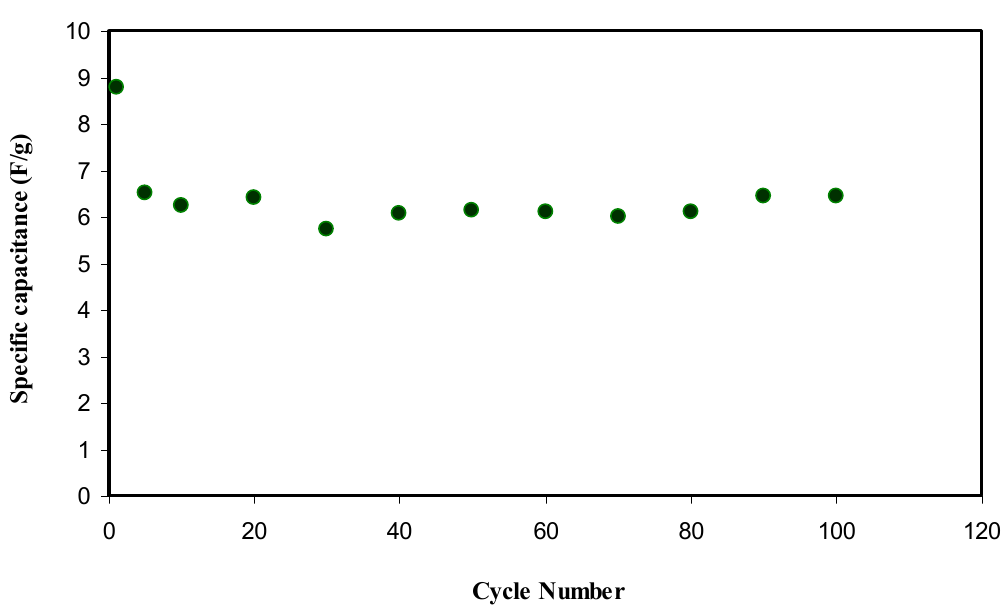
Figure 11. Charge-discharge profiles for the fabricated EDLC at 0.5 mA·cm − 2.